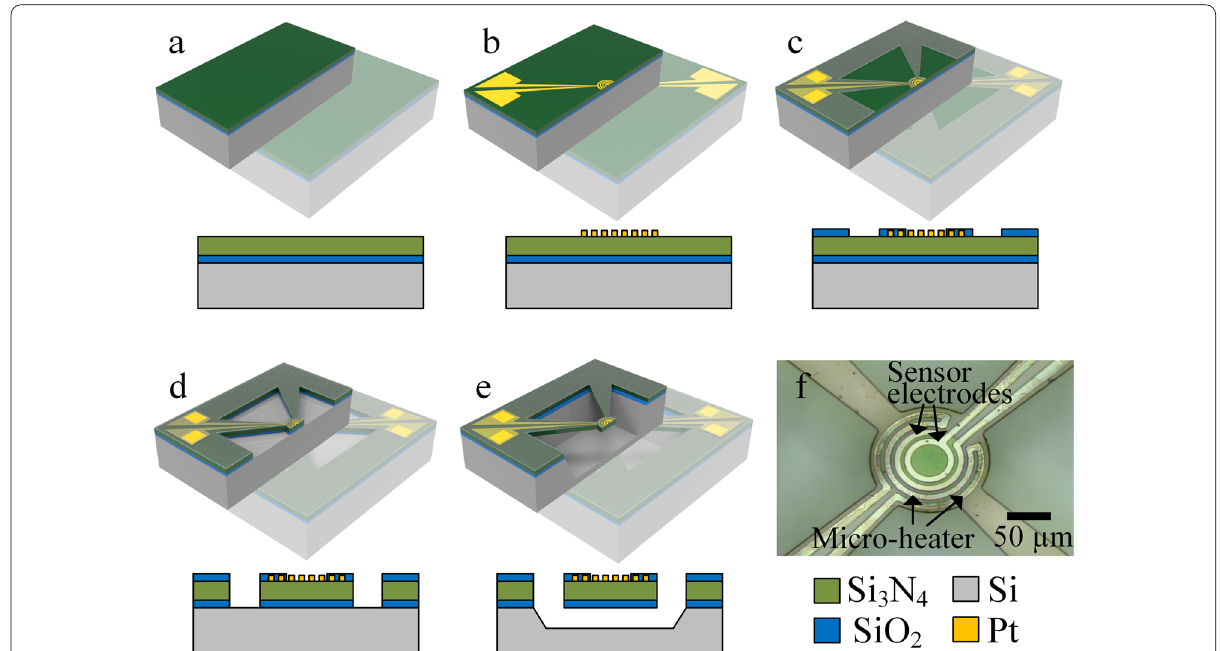
Fig. 1 Fabrication of the sensor platform with the suspended micro-heater. a Deposition of 500 nm-thick silicon nitride (Si 3 N 4 ) on a 300 nm-thick silicon dioxide (SiO 2 ) substrate through low-pressure chemical vapor deposition (CVD). b Deposition of a 25/250 nm-thick Ti/Pt film and patterning with photolithography and reactive ion etching (RIE) on the Si 3 N 4 /SiO 2 substrate. c Deposition of a 200 nm-thick SiO 2 film via plasma-enhanced CVD and patterning with photolithography and RIE, leading to the formation of a passivation layer for the heating element. d Photolithography and RIE to etch SiO 2 /Si 3 N 4 /SiO 2 layers for opening the bare Si layer. e Wet etching of the Si substrate using tetramethylammonium hydroxide to form the suspended structure. f Optical image of the fabricated sensor platform with the